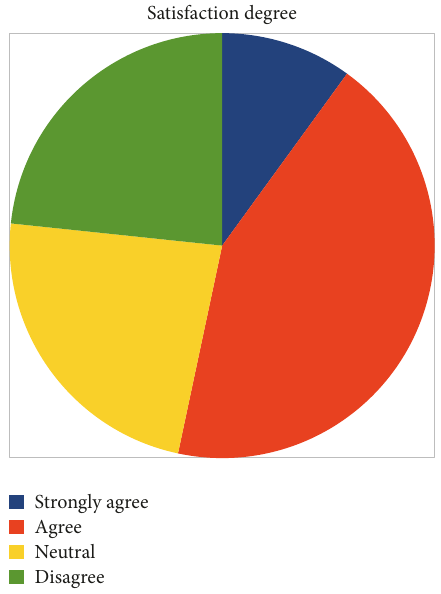
Figure 14: Results of the Turtle Robot course students question- naire, from